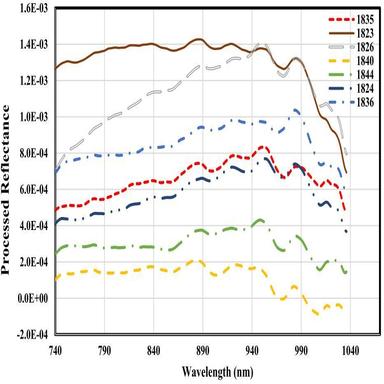
Fingerprint patterns of different asphalt mixtures.